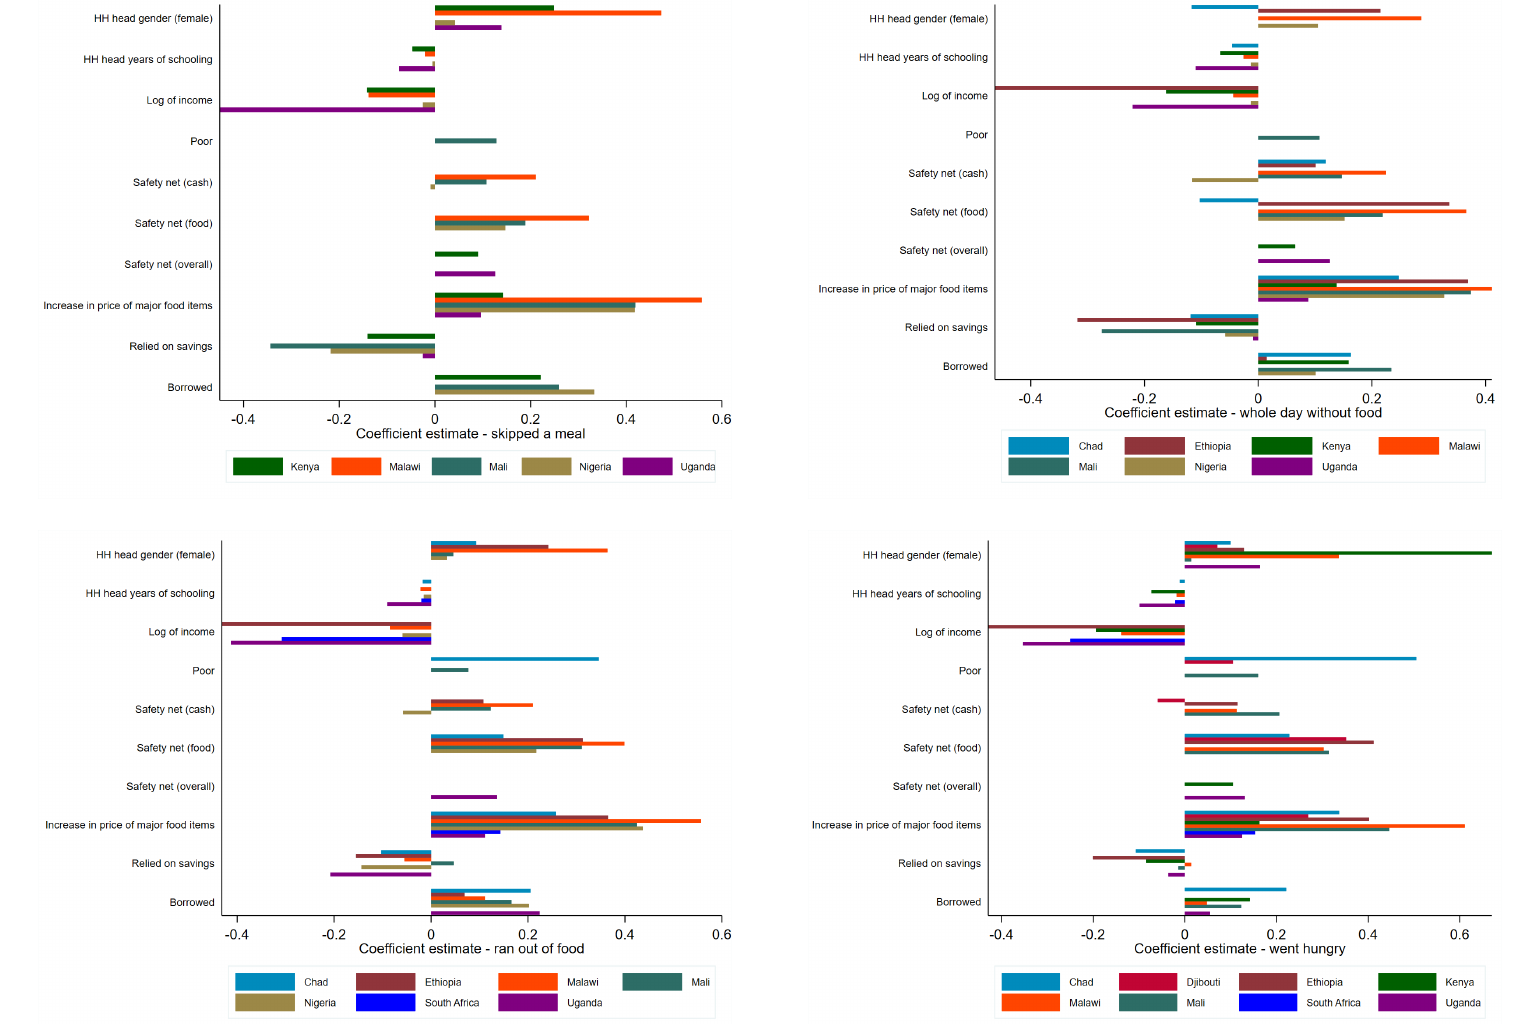
Figure 12. Regression coefficients—showing only statistically significant